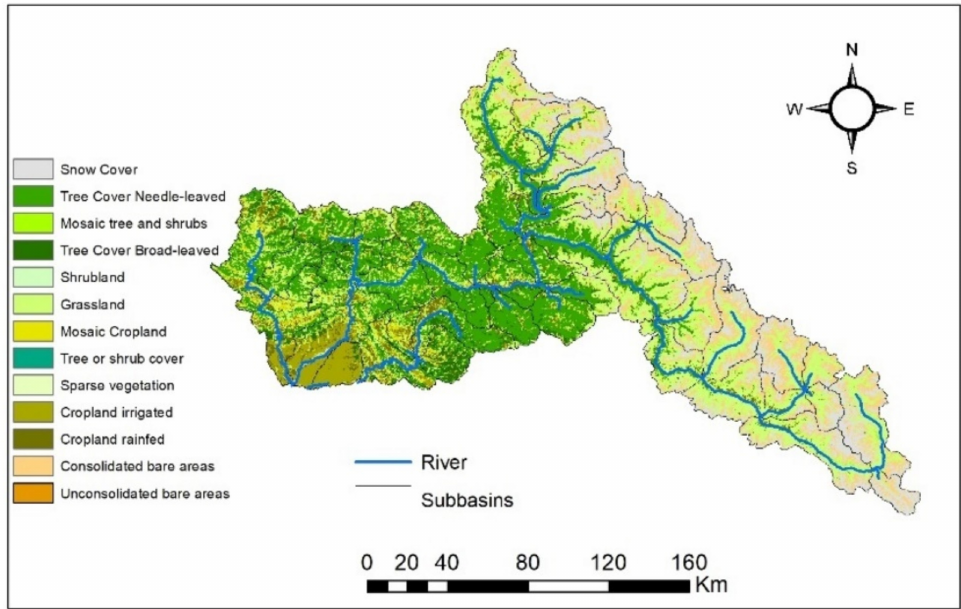
Figure 6. Land use of the Chenab river catchment developed using European Space Agency land